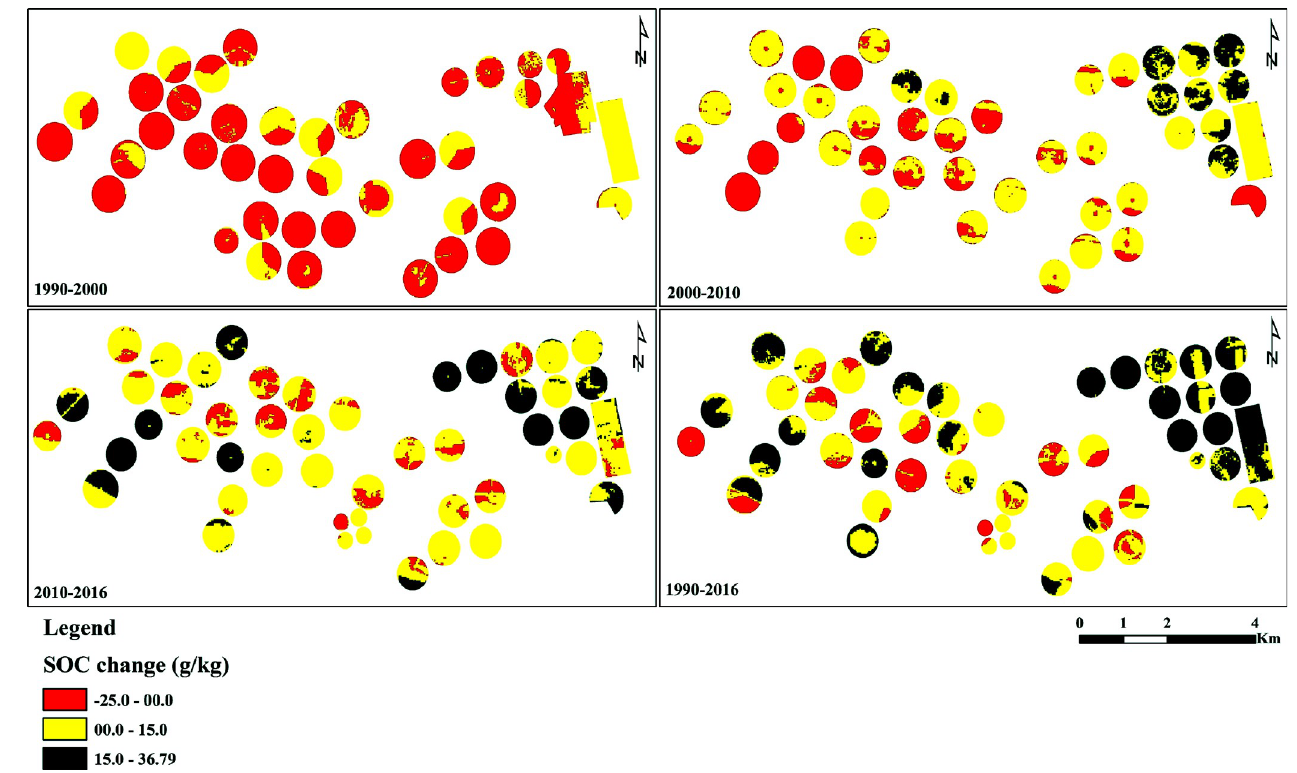
Fig 4. Changes in the SOC content of the experimental fields during the study